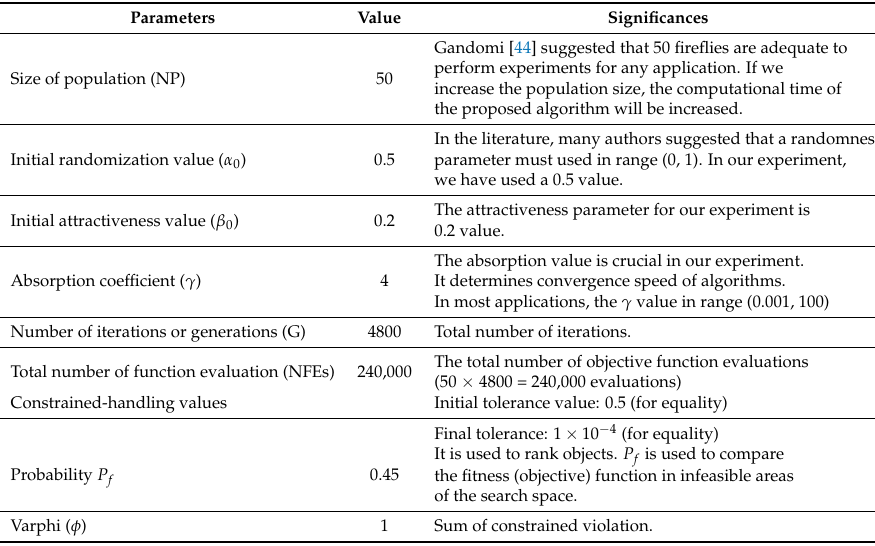
Table 2. Experimental parameters for